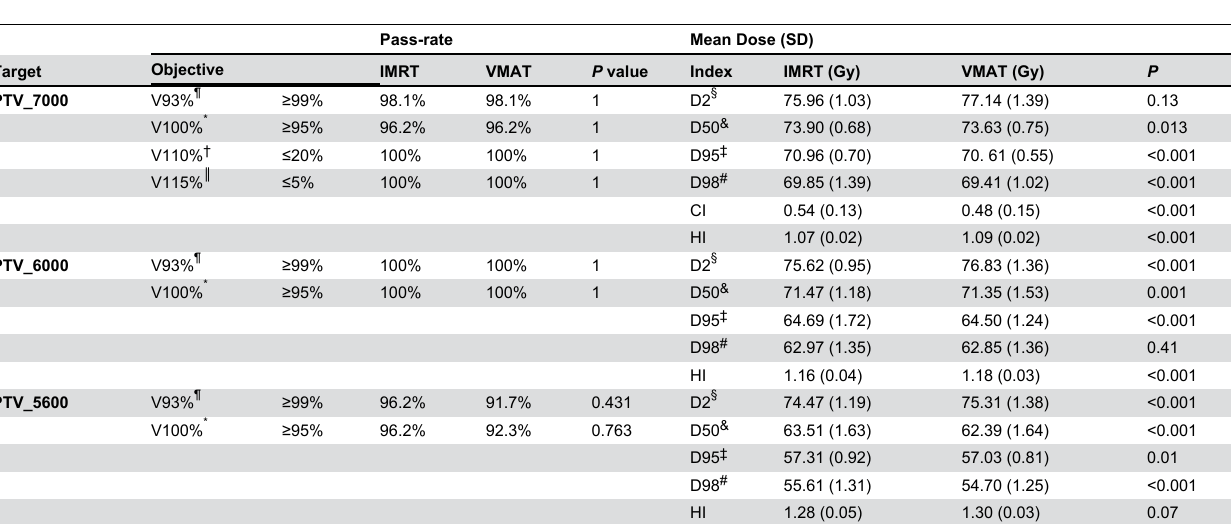
Table 1. Dosimetric comparison of VMAT and IMRT for the PTVs in 52 NPC